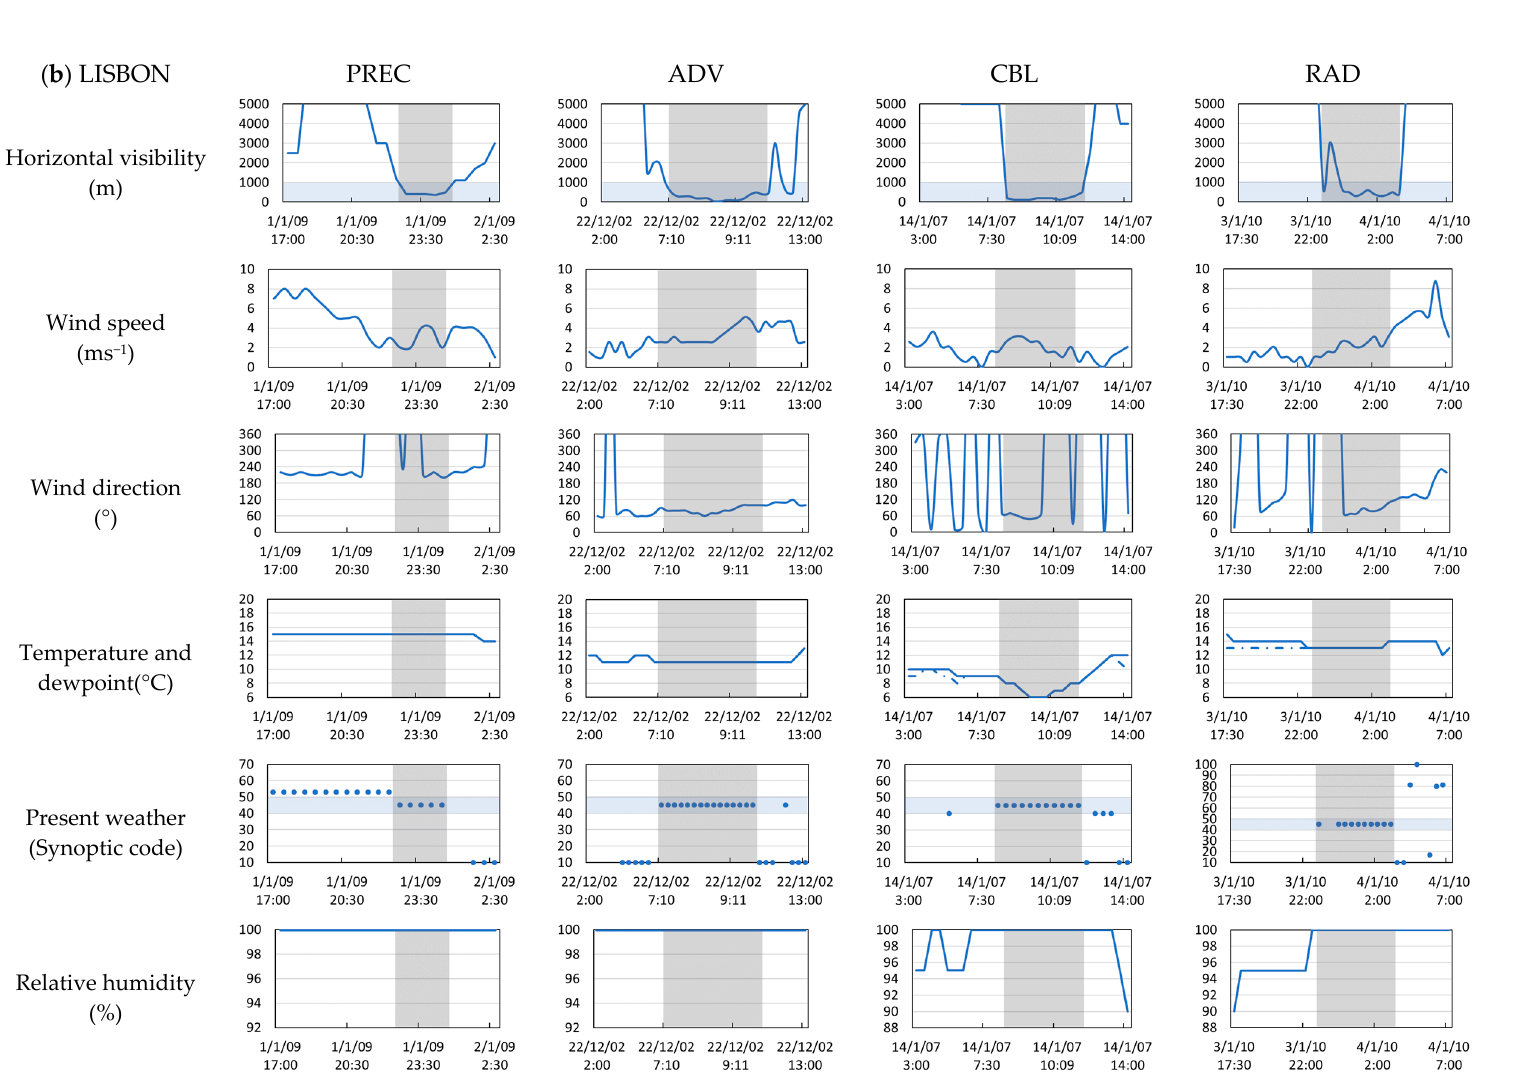
Figure 11. Surface observations of horizontal visibility at surface, 10 m wind speed and direction, 2 m temperature, 2 m dewpoint temperature, present weather and relative humidity associated to a fog event of each type, at the airports of Porto ( a ) and Lisbon ( b ). The fog event is indicated by the grey regions in the